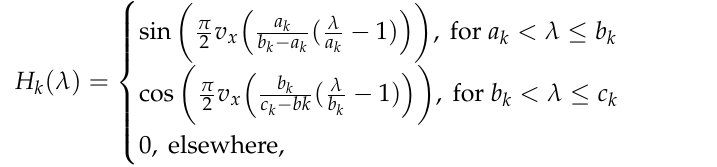
( λ p ) = 1 is satisfied, for a uniform splitting H 2 k k = 0